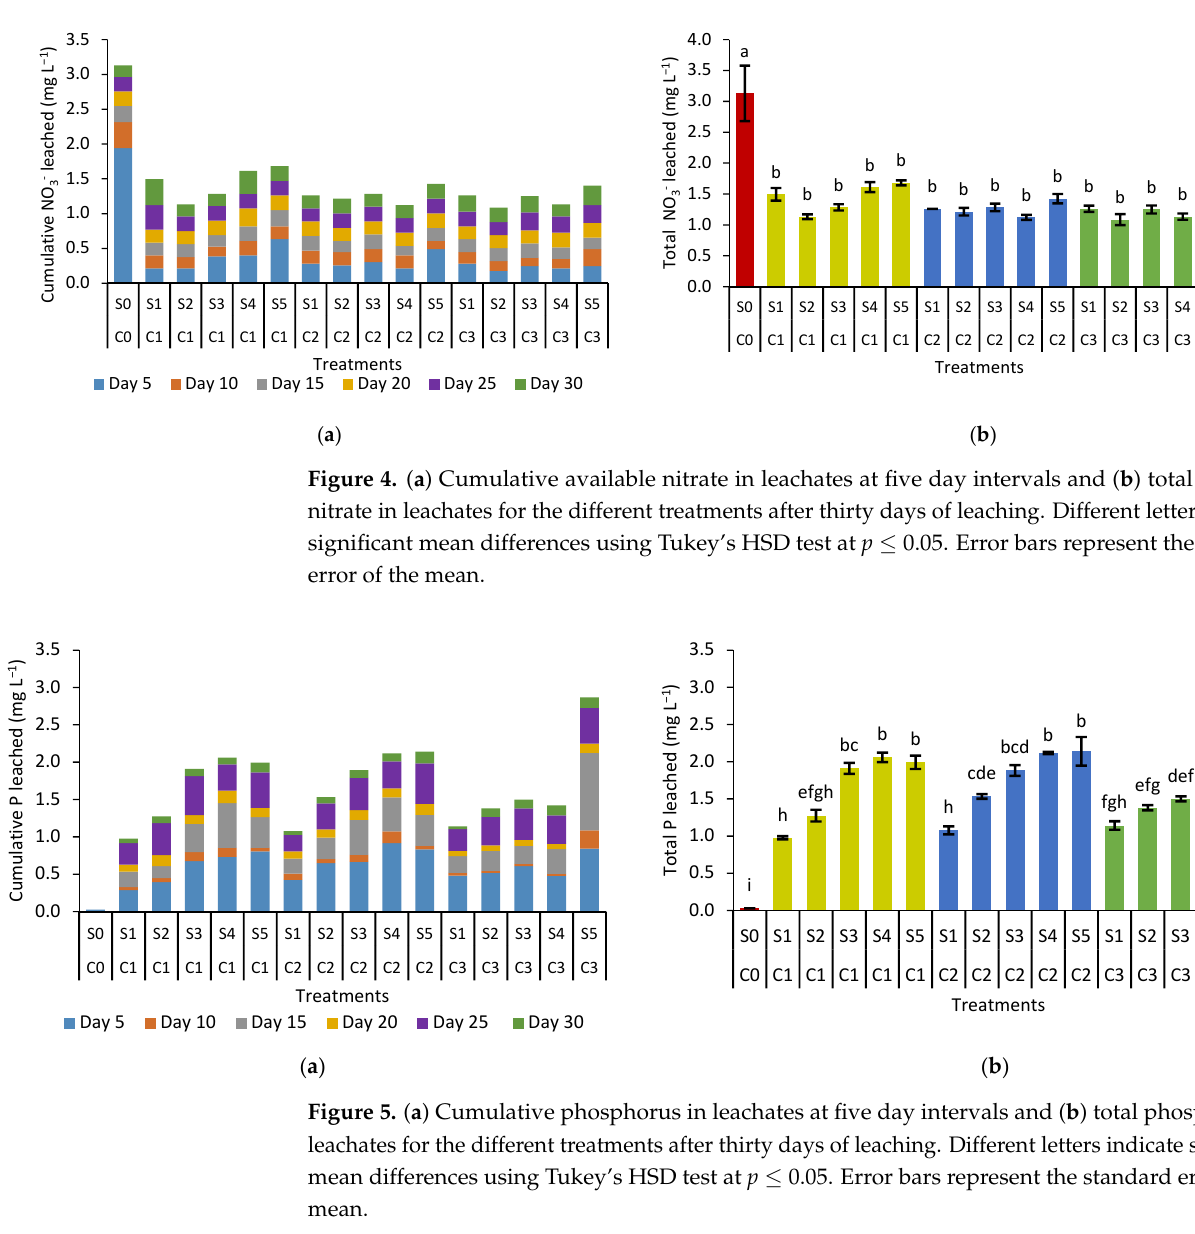
Figure 4. ( a ) Cumulative available nitrate in leachates at five day intervals and ( b ) total available nitrate in leachates for the different treatments after thirty days of leaching. Different letters indicate significant mean differences using Tukey’s HSD test at p ≤ 0.05. Error bars represent the standard error of the mean.